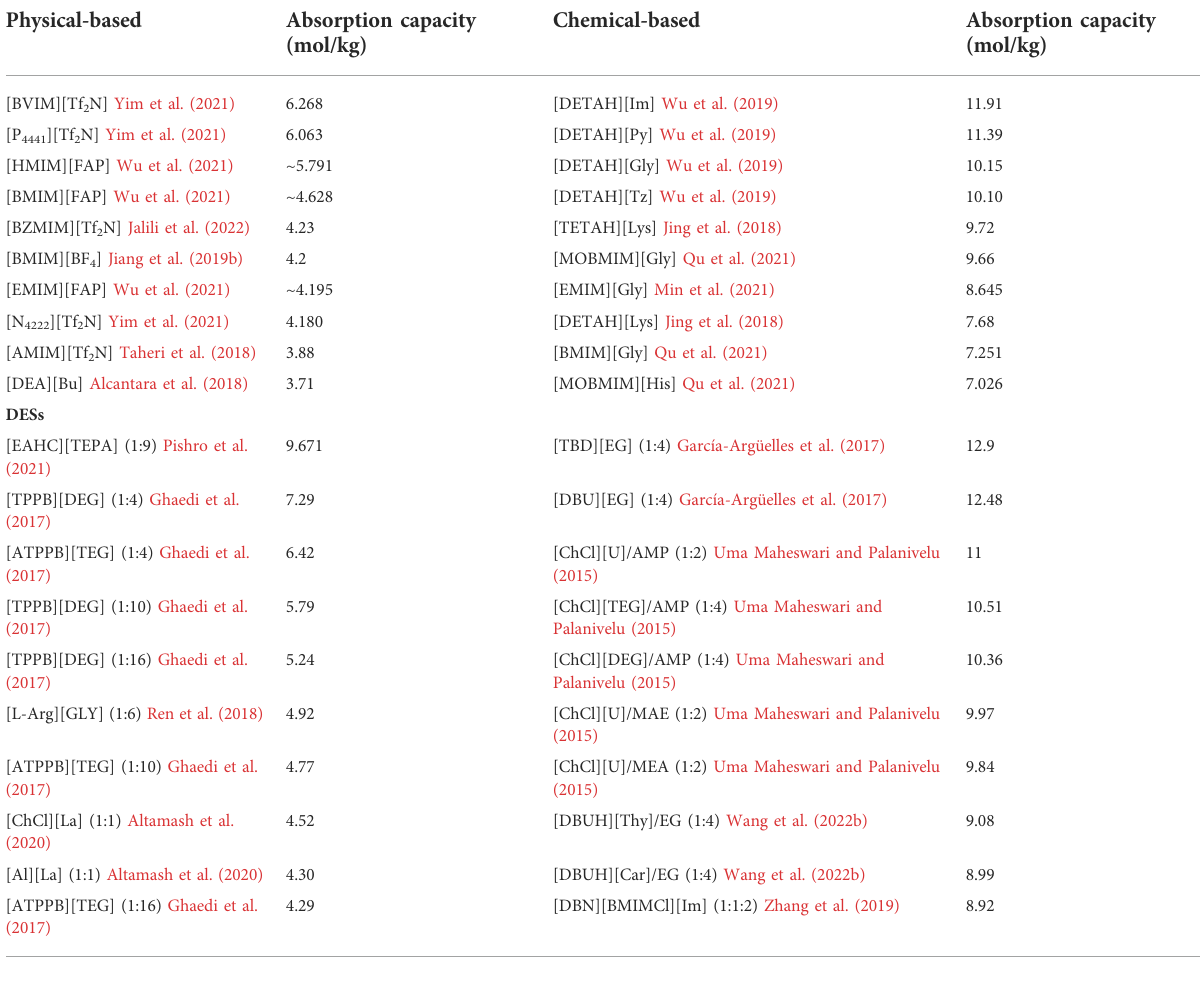
TABLE 5 10 physical- and chemical-based ILs and DESs with high CO 2 absorption capacity. ILs Physical-based Absorption capacity (mol/kg)